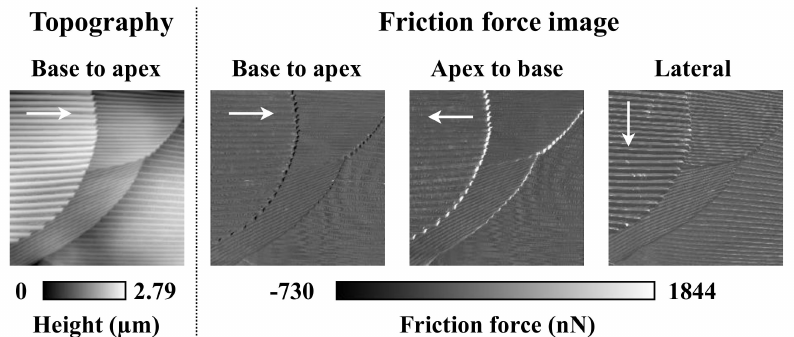
Figure 4. Topography and friction force images obtained by AFM with a needle probe. White arrows show the scanning direction. The body part measured was the dorsal pronotum, and the scanning area was 50 µ m × 50 µ m.